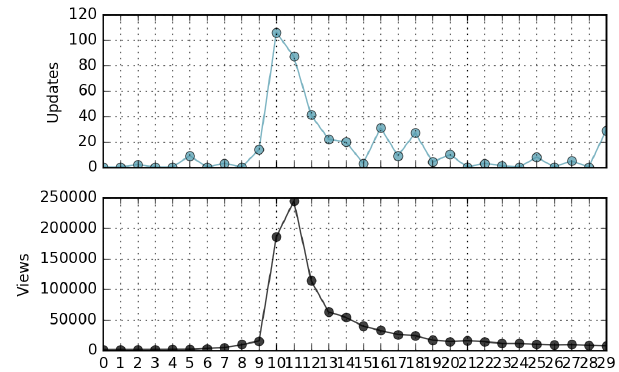
Figure 9. Views and updates of a popular science page (“Gravitational wave”) in February 2016, from 1 February to 1 March.